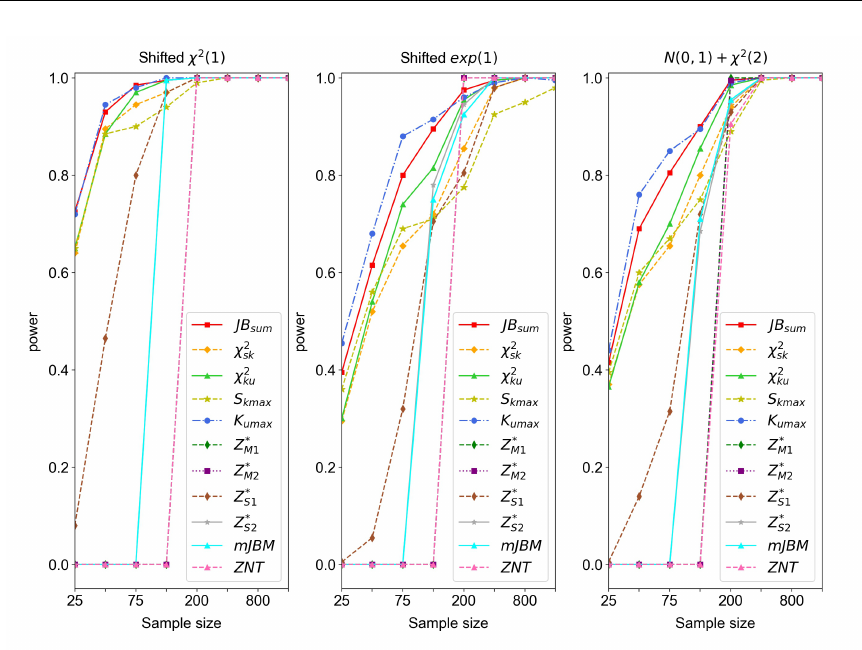
Figure 4. Empirical power of proposed PC-type JB testing compared with other methods ( p =